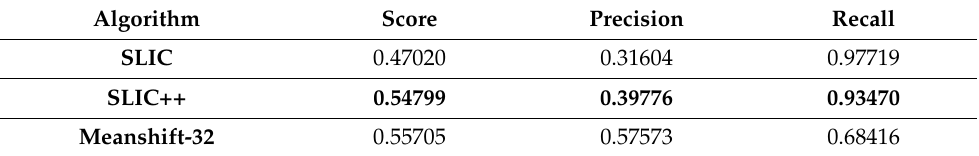
Table 4. Summary statistics of average performance for Berkeley